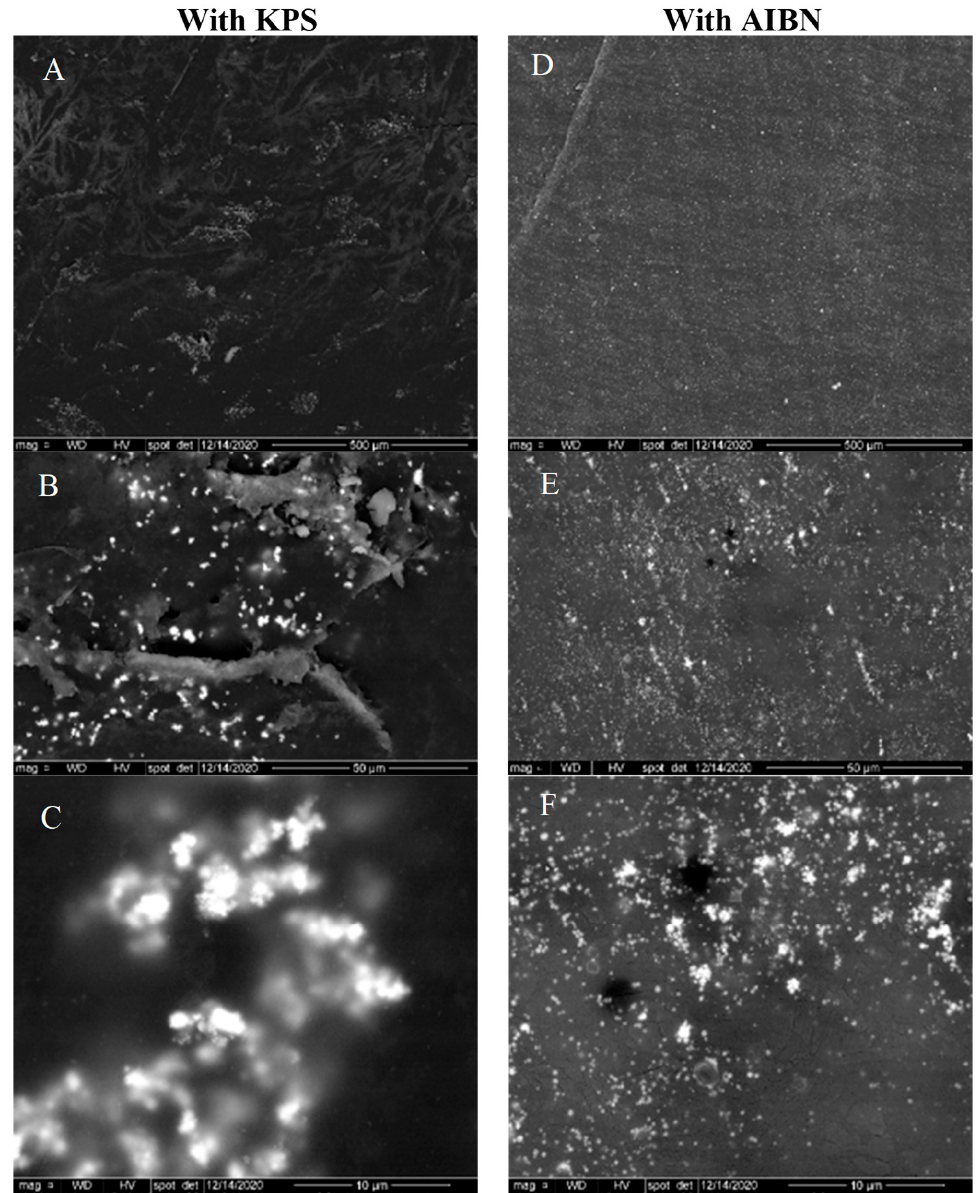
Figure 2. SEM’s pictures of free films containing 1% of AgNPs prepared using KPS ( A – C ) or AIBN ( D – F ) as initiator.